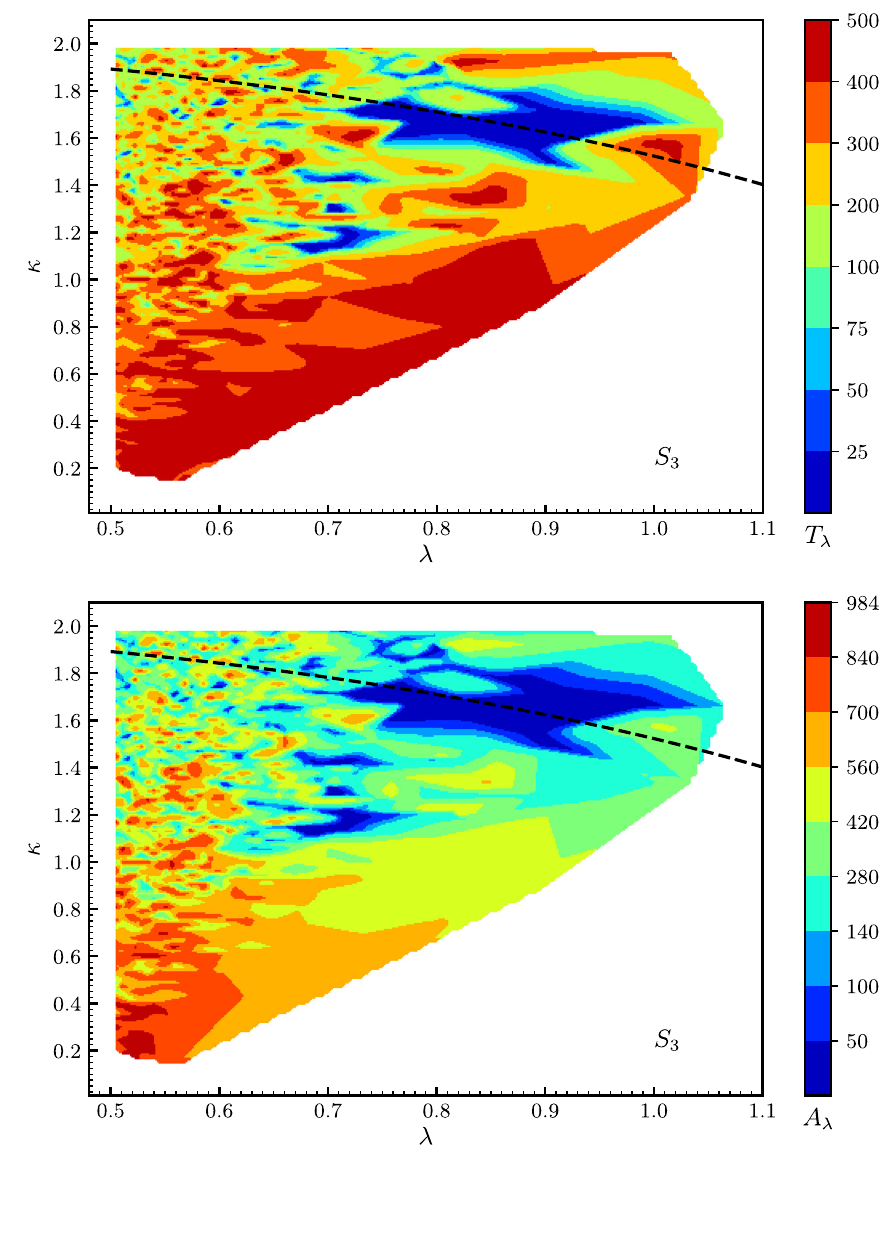
Fig. 34 The same as in Fig. 32, but the colours indicate different low-energy values of the trilinear soft terms T λ